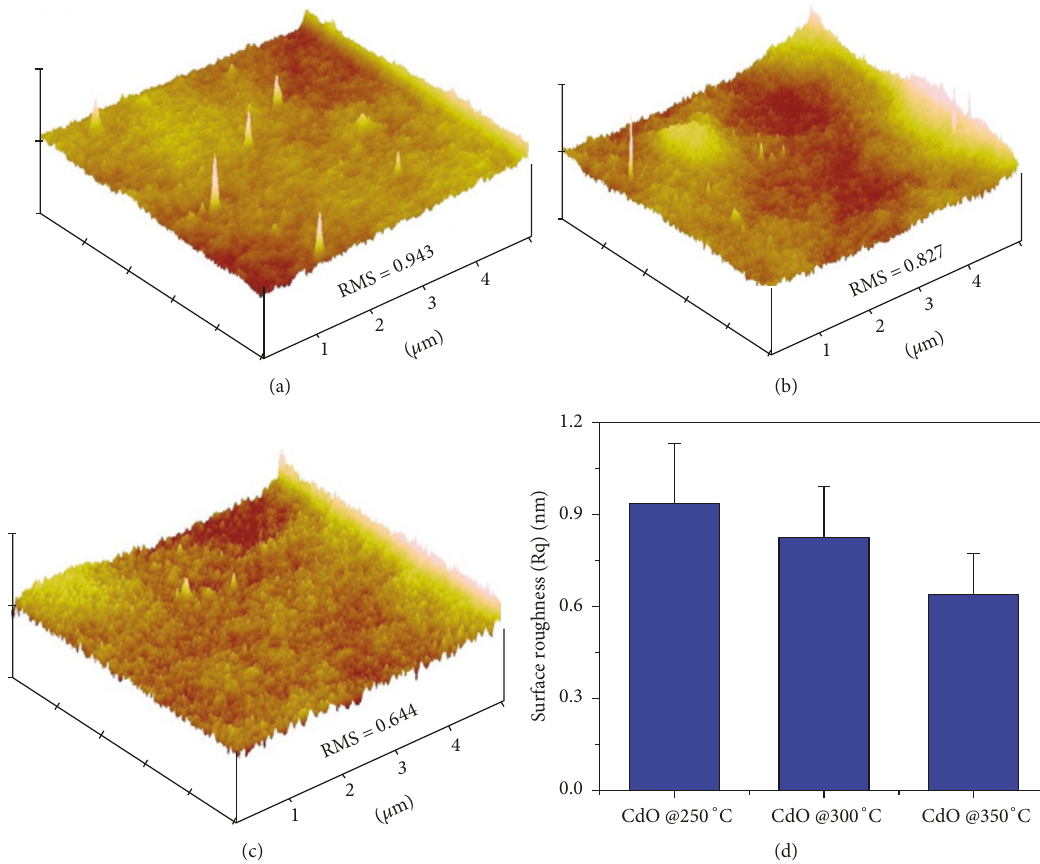
Figure 9: 3D AFM height profiles of CdO thin films deposited at 250 ∘ C (a), 300 ∘ C (b), and 350 ∘ C (c) and the surface roughness in terms of root mean square (RMS) roughness (Rq) (d) for scan size of 5.0 𝜇 m × 5.0 𝜇